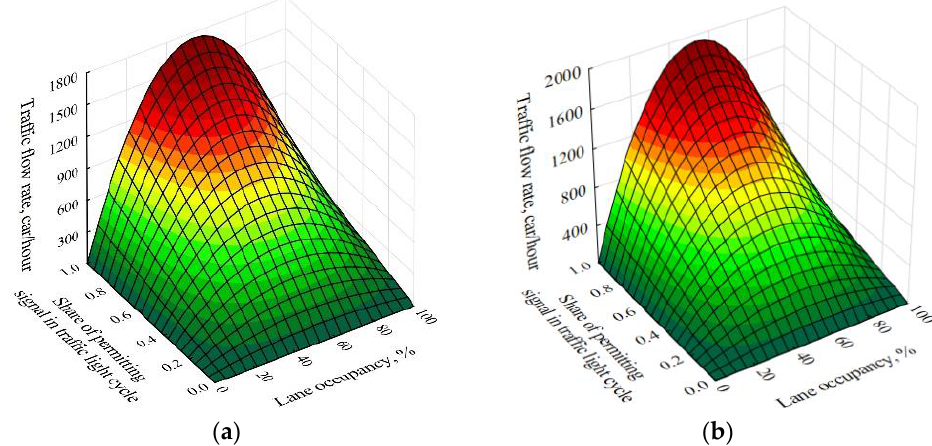
Figure 1. The combined influence of lane occupancy and traffic light cycle on the traffic flow rate: ( a ) in a left-turn: ( b ) forward directions of the traffic flow. ( a ) in a left-turn: ( b ) forward directions of the traffic